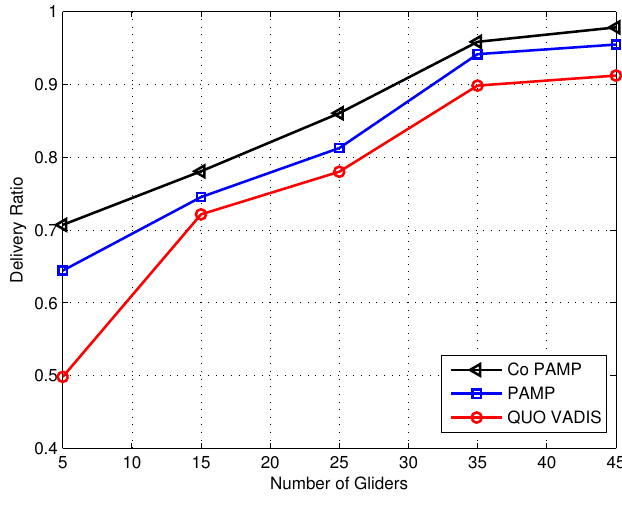
Figure 8. Delivery ratio comparison.